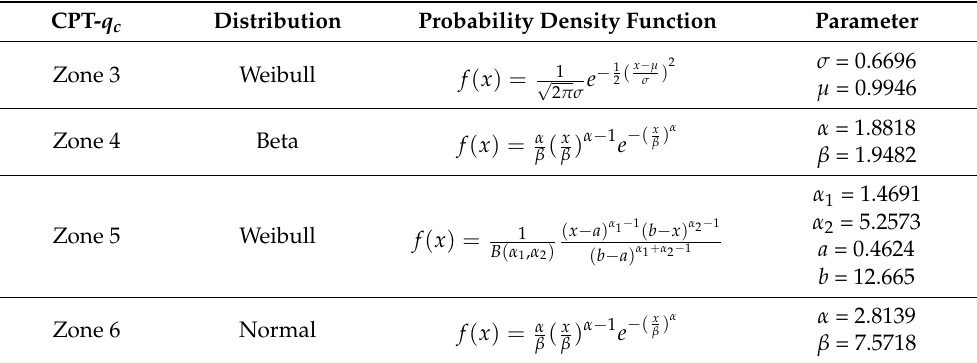
Table 2. Statistical parameters of CPT- q c probability distribution for SBT